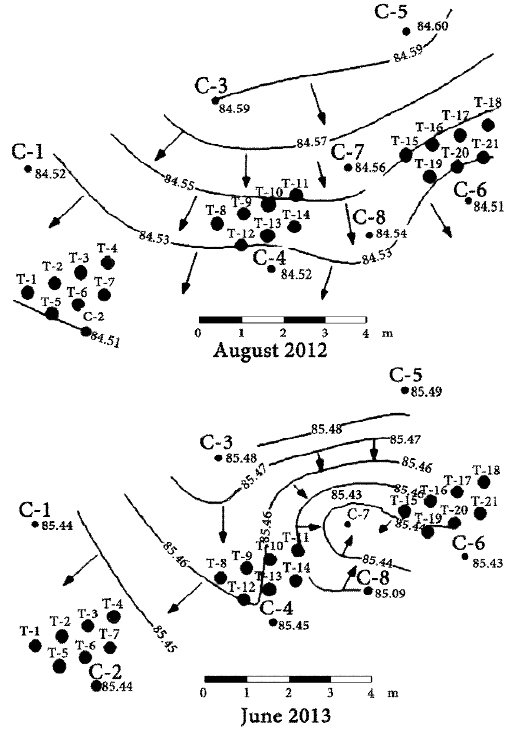
Figure 7. The change of groundwater flow direction ( ) during the period of observation.